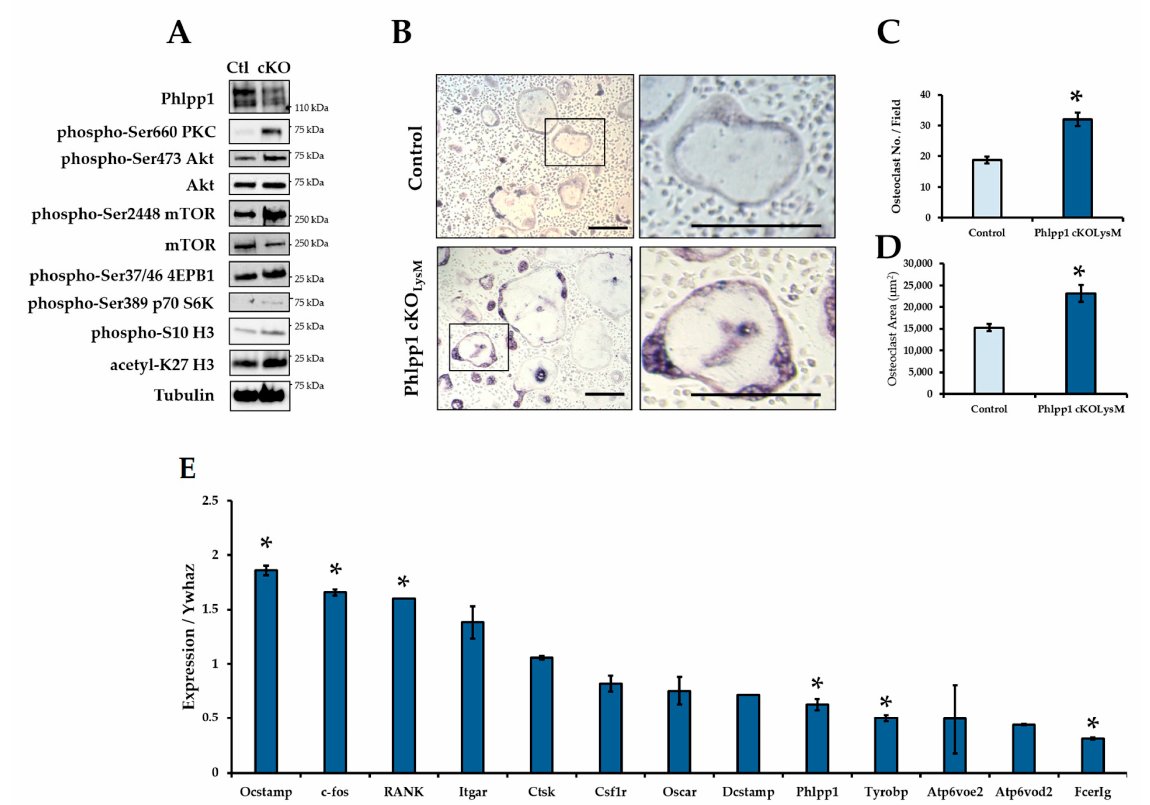
Figure 3. Conditional deletion of Phlpp1 enhances ex vivo osteoclastogenesis . Osteoclasts were generated from bone mar- row macrophages collected from 6–8-week-old Phlpp1 cKO LysM females or their sex-matched littermate controls. Samples were collected on day 4 and ( A ) Western blotting was performed. ( B ) TRAP staining of control or Phlpp1 cKO LysM cultures was performed. Insets in the left panels denote locations of higher magnification images shown in left panels. ( C ) Number of osteoclasts and ( D ) average osteoclast area per field were determined, * p < 0.05. ( E ) Expression of osteoclast phenotypic markers was assessed by qPCR, * p < 0.05. Scale bars are 100 microns.